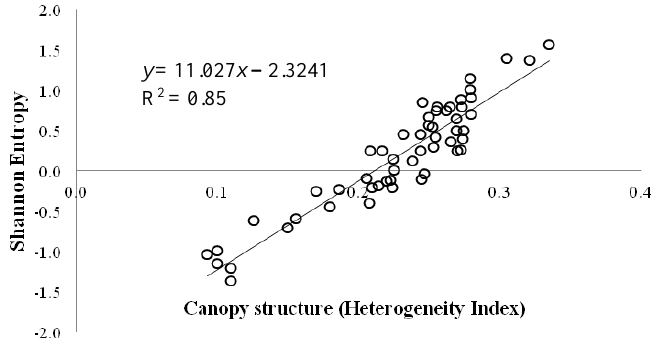
Figure 7. Linear regression between the Shannon entropy index and the heterogeneity structure